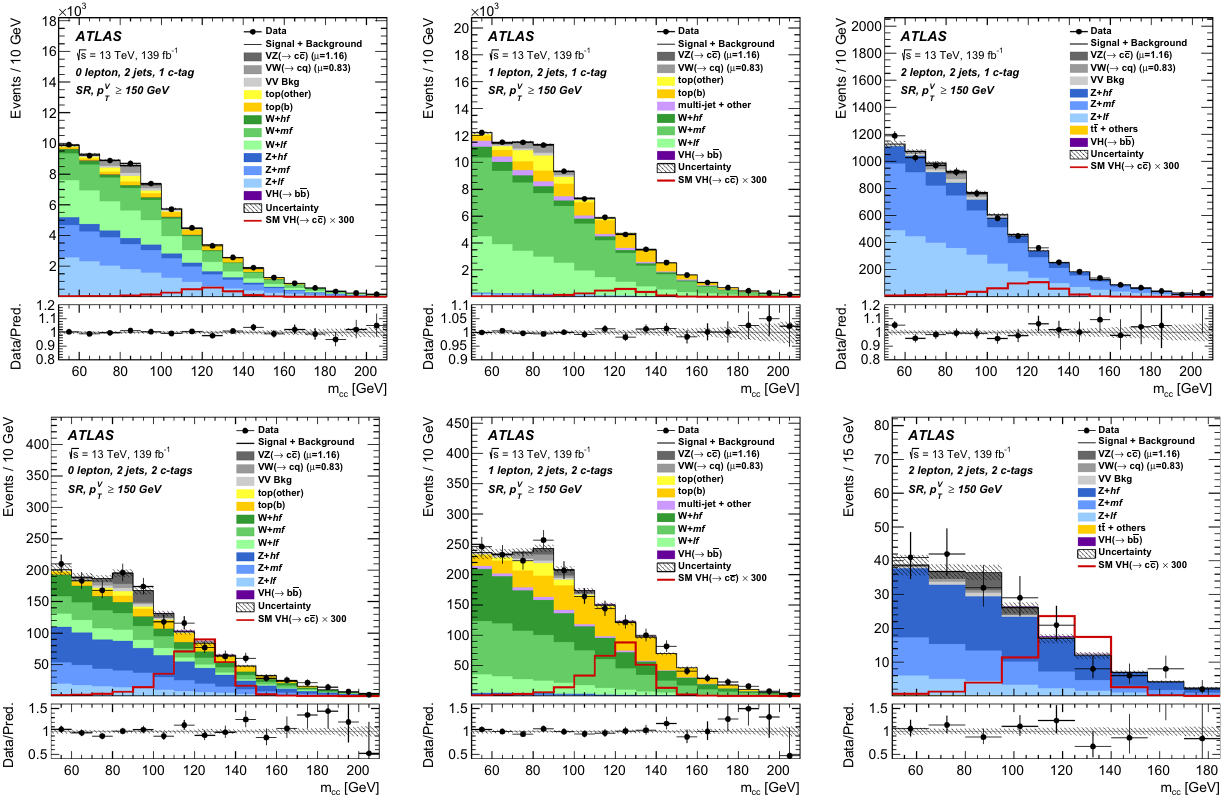
Fig. 1 Post-fit distributions for six selected signal regions out of 44 scaled to the best-fit value of μ VH ( c ¯ c ) = − 9. The H → c ¯ c signal is also > 150 GeV for the 0-lepton analysis regions, with two jets and p V shown as an unfilled histogram scaled to 300 times the SM prediction. T The post-fit uncertainty is shown as the hatched background. The ratio (left), 1-lepton (centre), and 2-lepton (right) channels, with one c -tag of the data to the sum of the post-fit signal plus background is shown (top) and two c -tags (bottom). The total signal-plus-background pre- in the lower diction is shown by the solid black line and includes the H → c ¯ c signal